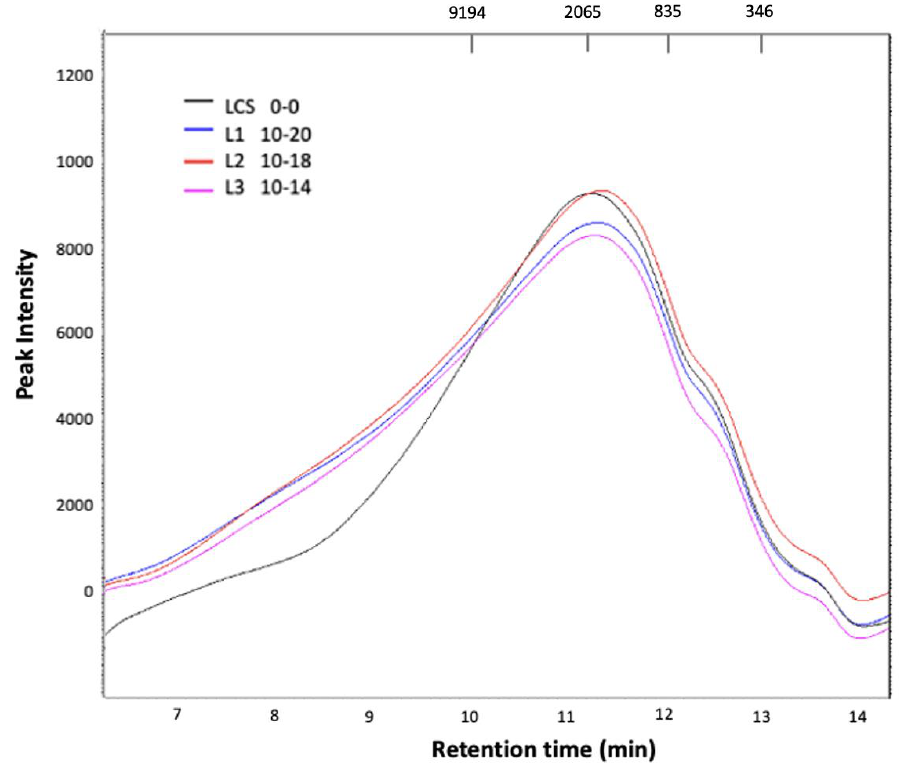
Figure 9. High-performance liquid chromatography of lignin from sorghum organosolv without LCS and by applying high-power ultrasonic pulses. (L1) Lignin treatment time/amplitude—10/20. (L2) Lignin treatment time/amplitude—10/18. (L3) Lignin treatment time/amplitude—10/14. The molecular weights of the standards are shown at the top (g/mol). Table 7. Assignment of molecular weights of lignin organosolv from sorghum with and without application of high-power pulses. t R , Retention time at maximum peak intensity; Mw, Molecular weight. Lignin treatment time/amplitude: (LCS) 0/0; (L1) 10/20; (L2) 10/18; (L3) 10/14.